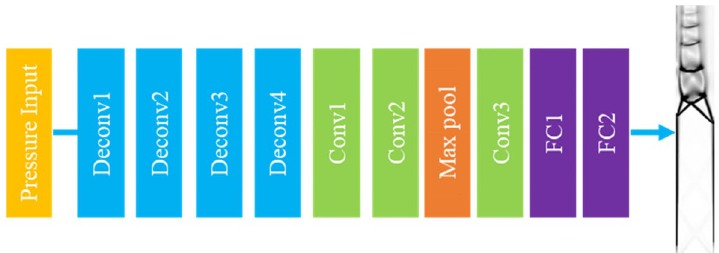
Fig. 6 Flow field reconstruction model based on CNN